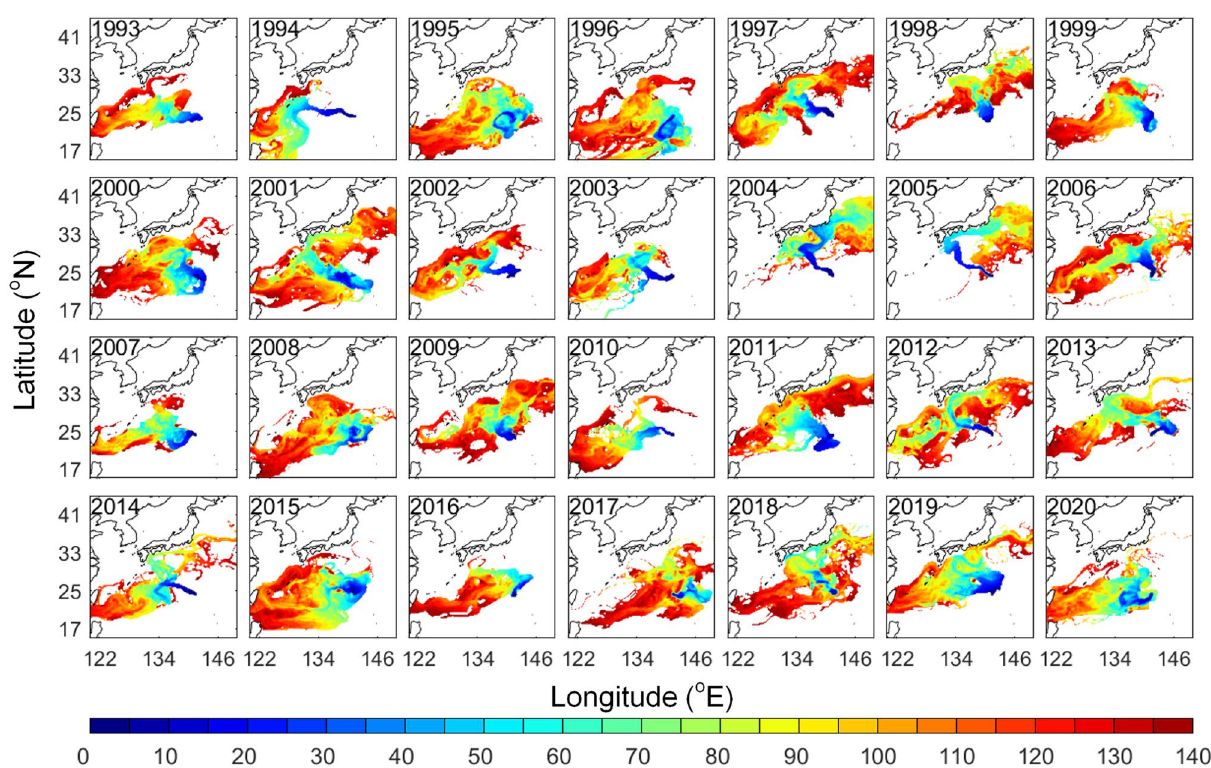
Figure 6. Time-evolving distribution (days) from 1993 to 2020 based on 2% windage. Figure is created using MATLAB R2011b (http:// www. mathw orks.